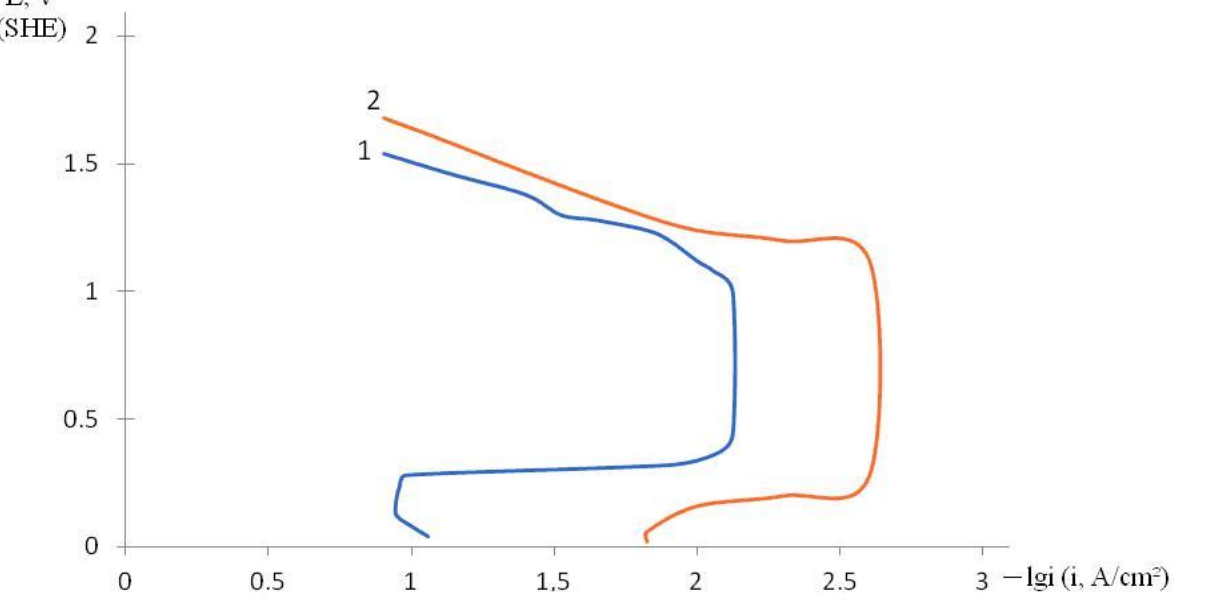
Figure 5. E–lg I curves of Ni (1) and Ni–GO CEC (2) in 0.5 M H 2 SO 4 (coatings were deposited at cathode current density i c = 8 A/dm 2 ).